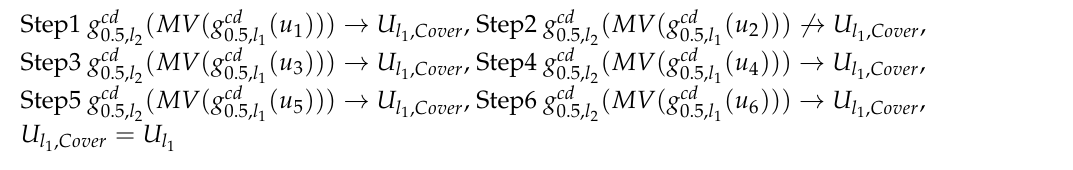
, A , d ) , temp 1 = MV ( g cd 2